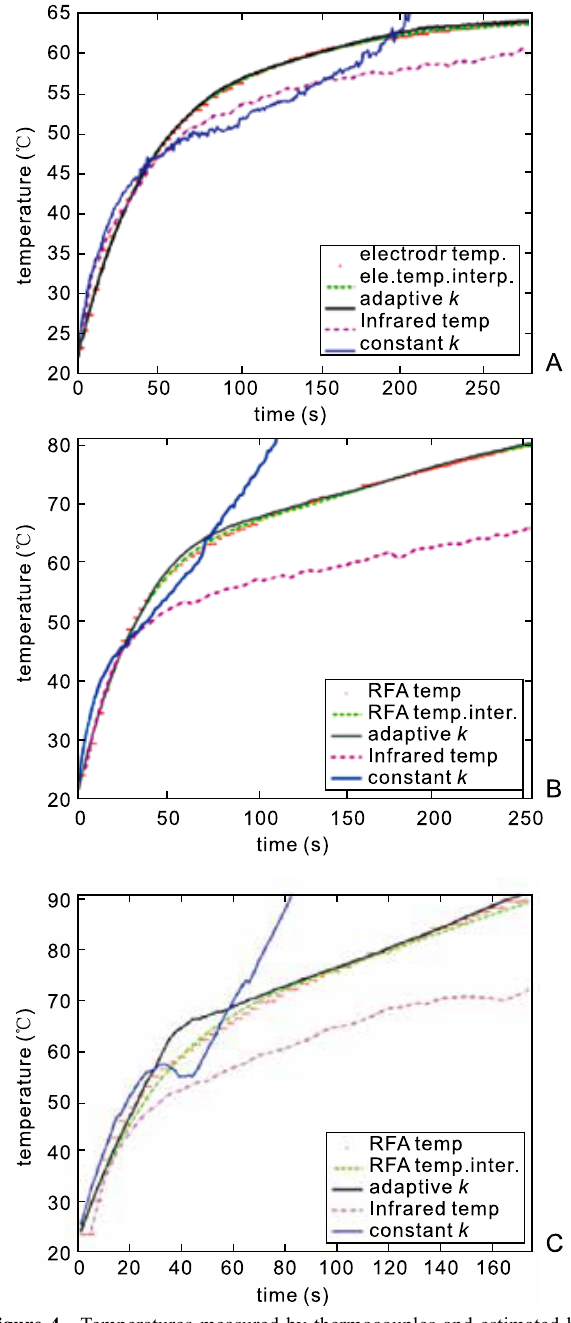
Figure 4 Temperatures measured by thermocouples and estimated by UTSI with constant- and adaptive- k algorithms as a function of ablation time during RFA of different powers: (A) 10W; (B) 15W; (C) 20W